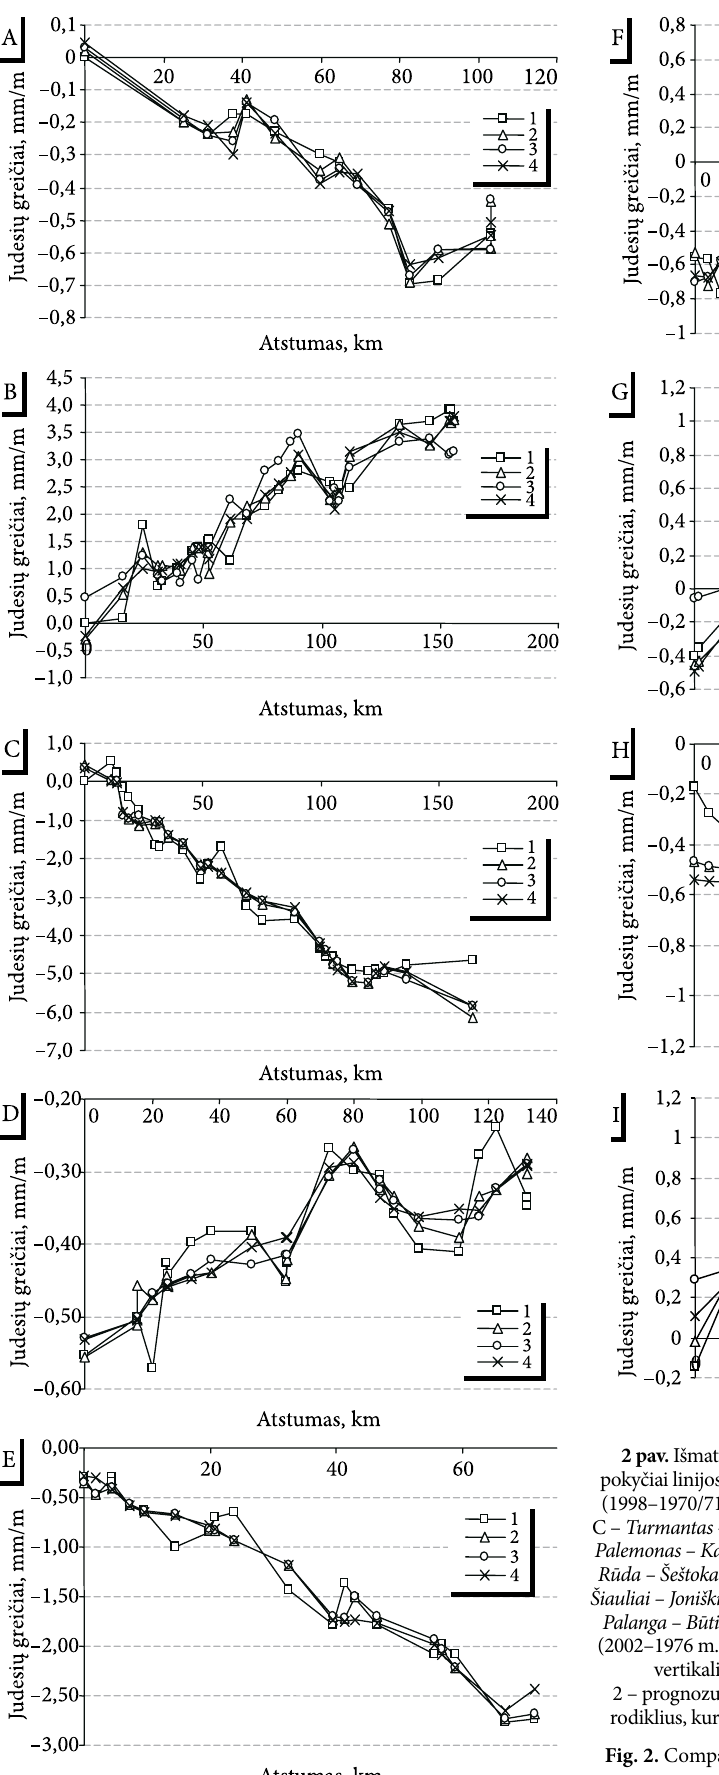
Fig. 2. Comparison of measured and modelled vertical movements of the earth‘s